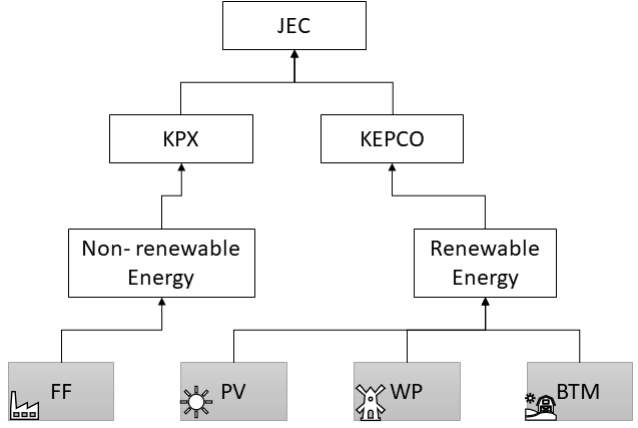
Figure 2. Power sources of renewable and nonrenewable energy for Jeju